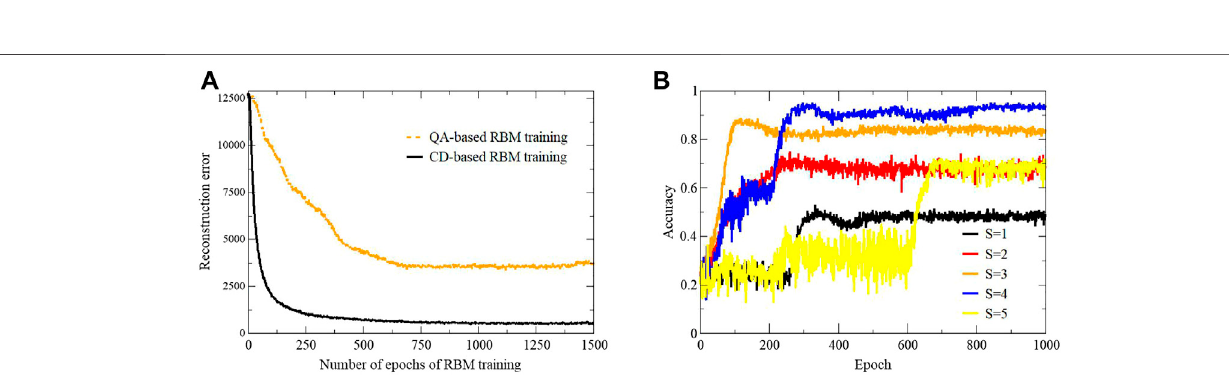
Frontiers in Physics |